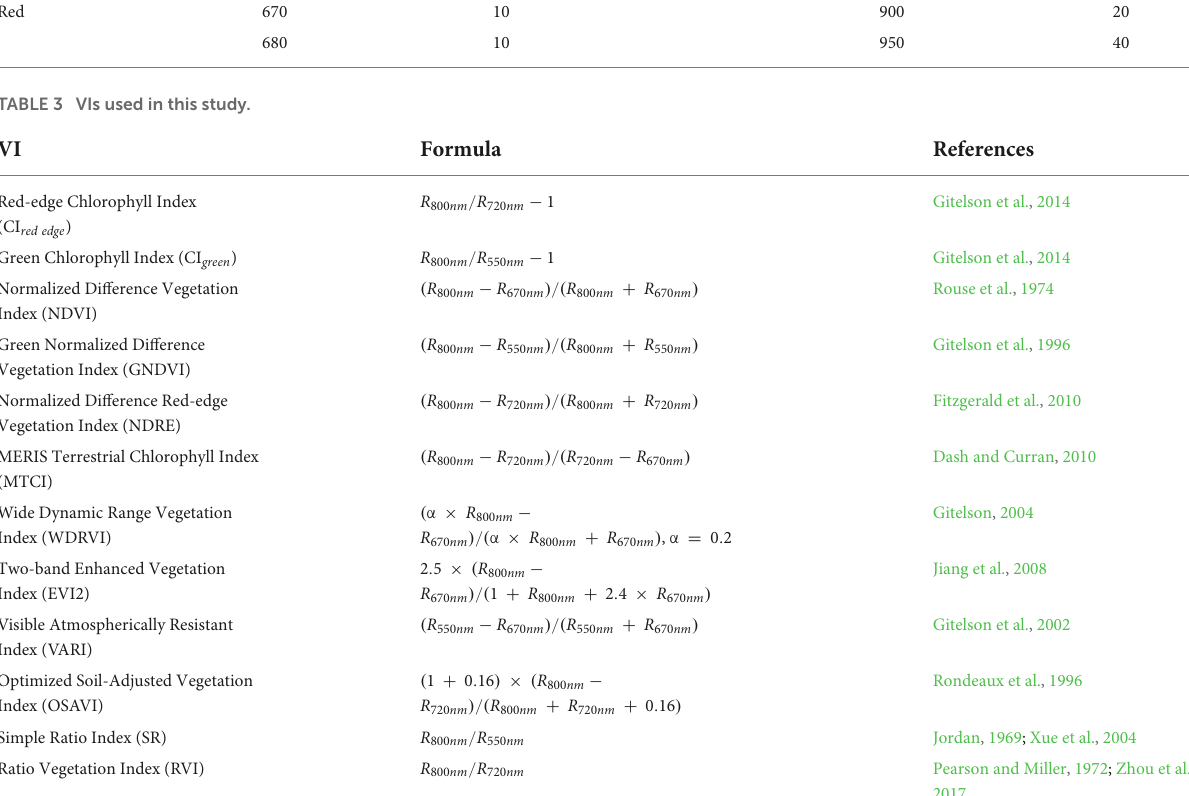
TABLE 3 VIs used in this